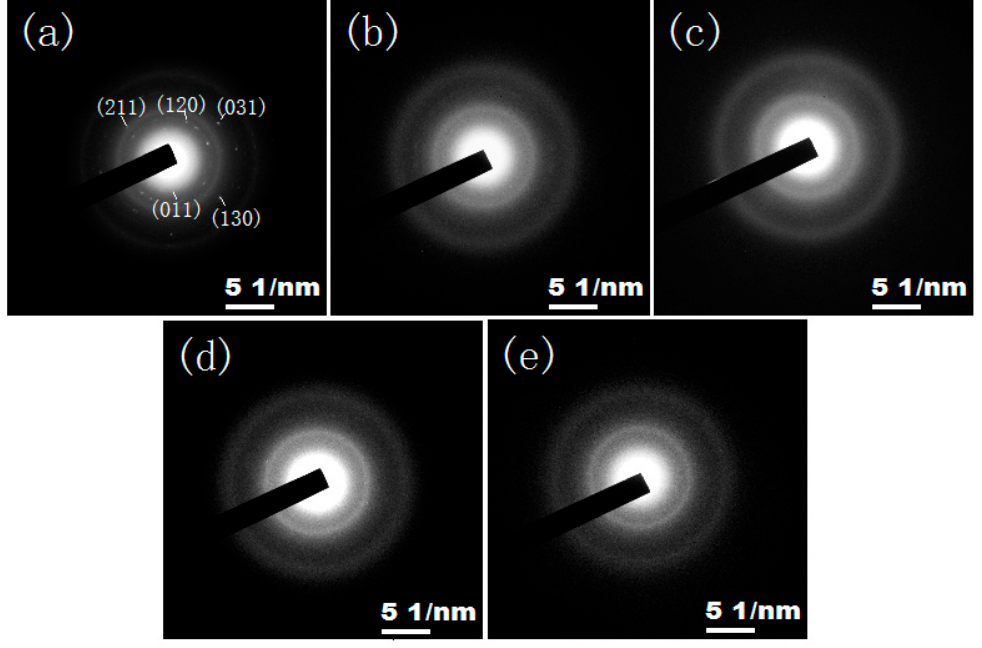
Figure 7. SAED patterns of FeSe 2 /C prepared with different Se/Fe ratios. ( a ) Se/Fe = 2.0; ( b ) Se/Fe = 2.5; ( c ) Se/Fe = 3.0; ( d ) Se/Fe = 3.5; ( e ) Se/Fe =